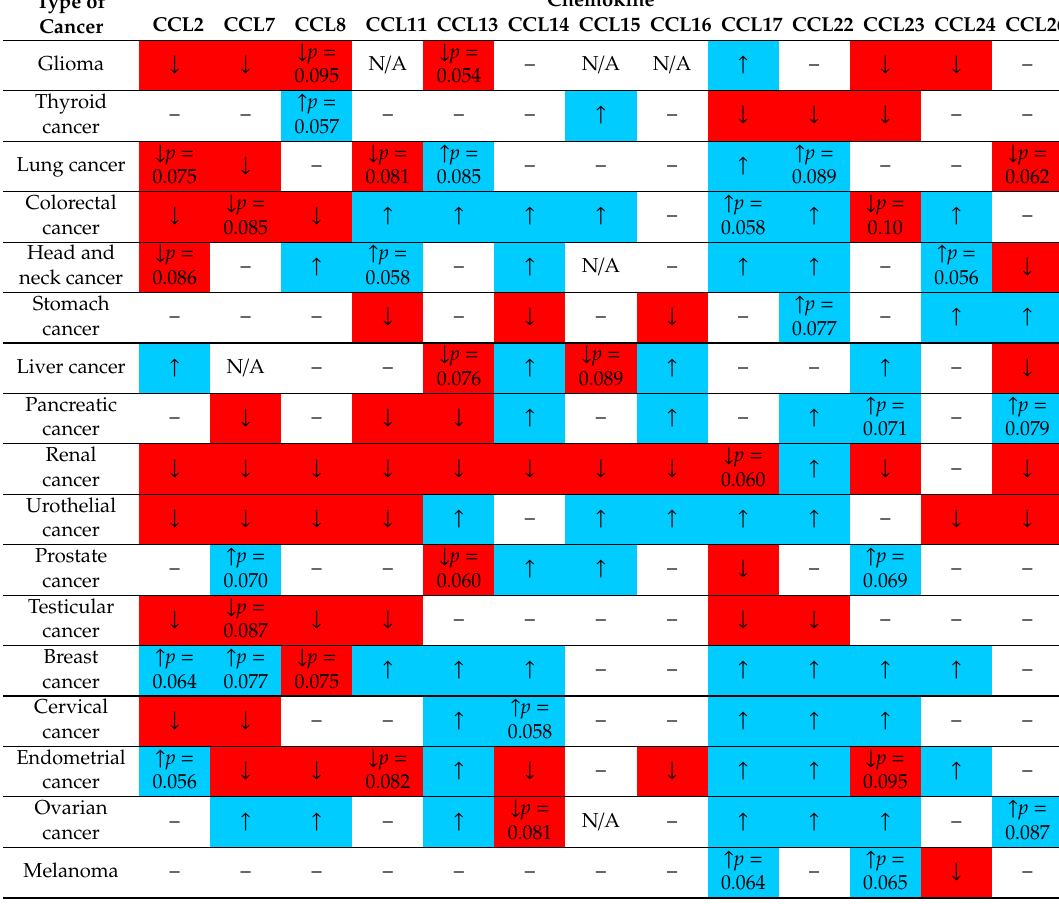
Table 1. Influence of increased expression of individual CC chemokines discussed in this review on the prognosis of patients with various cancers according to “The Human Protein Atlas” (https: // www.proteinatlas.org / )